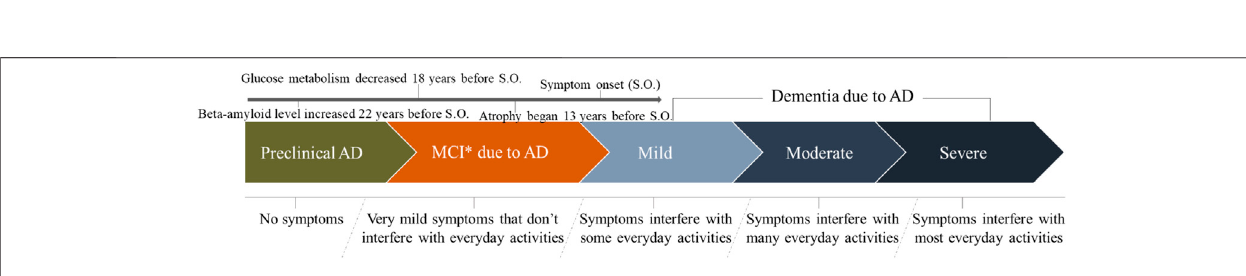
FIGURE 3 | The development progression of Alzheimer ’ s disease in clinical